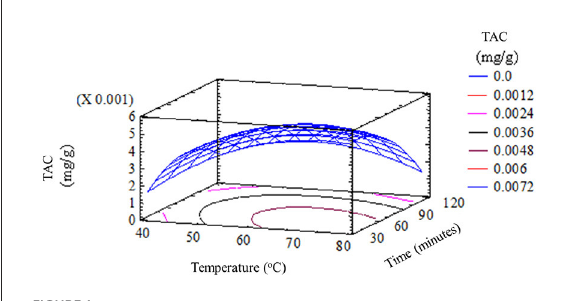
FIGURE1 Effect of extraction temperature and time on the TAC in garlic husk.